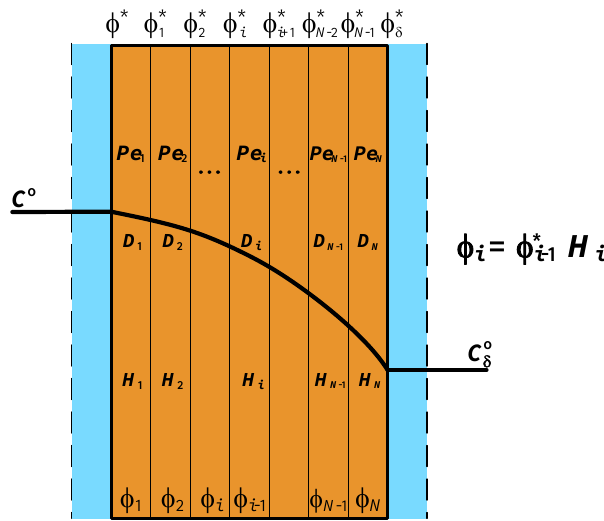
Figure 1. Division of an inhomogeneous (anisotropic) or composite membrane into N thin sublayers, in which the transport parameters, namely the diffusion coefficient ( D i ) and Peclet numbers ( Pe i ), as well as the solubility coefficients ( H i ), are constant .